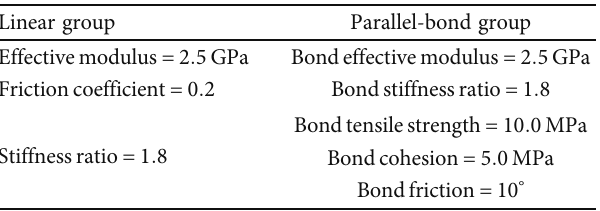
Figure 8: Numerical simulation (a) [35] in this paper and numerical simulation (b) [31] by Yuan et al. Table 2: Microscopic parameters of limestone